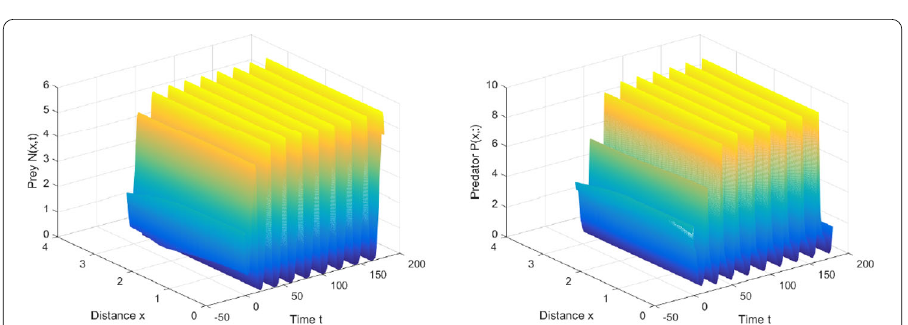
Figure 4 System (4) has spatially homogeneously periodic solution when time delay τ =